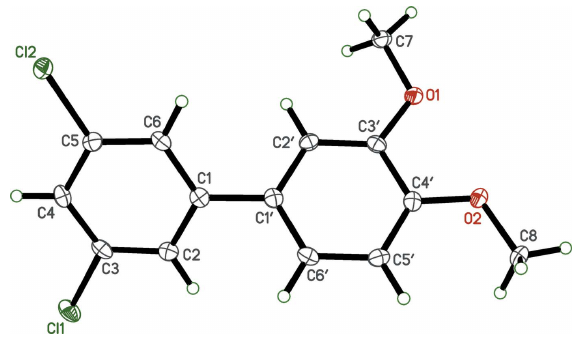
Figure 1 View of the title compound showing the atom-labelling scheme. Displacement ellipsoids are drawn at the 50% probability